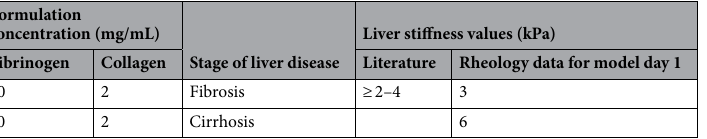
Table 2. Formulation composition, correspondence to stage of liver disease and known liver stiffness values and measured stiffness values 7 .